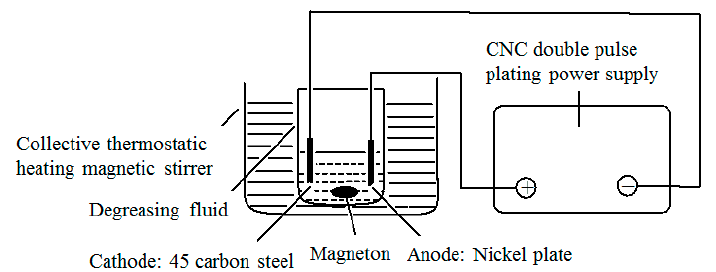
Figure 3. Diagram of the pulse plating reaction unit.